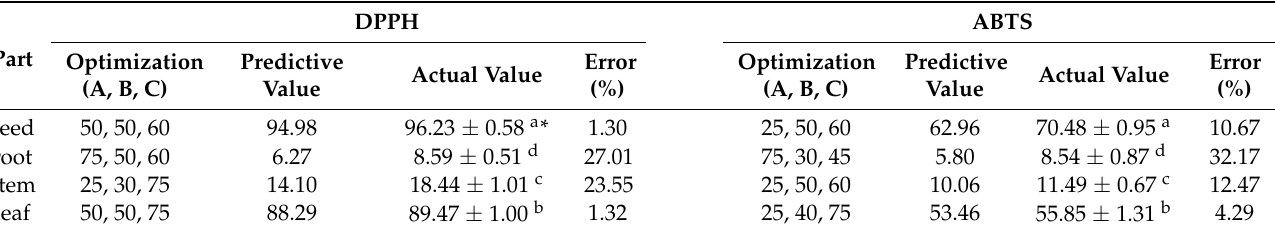
Table 4. The summary of antioxidant capacity and conditions of each part.